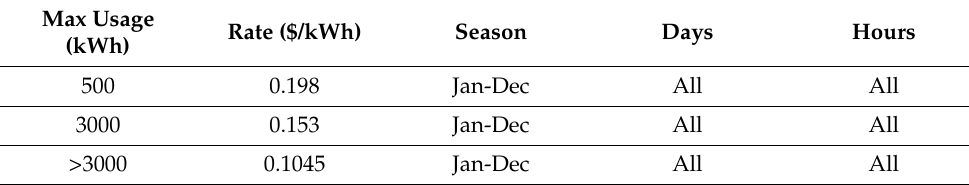
Table A6. Rate C (City of